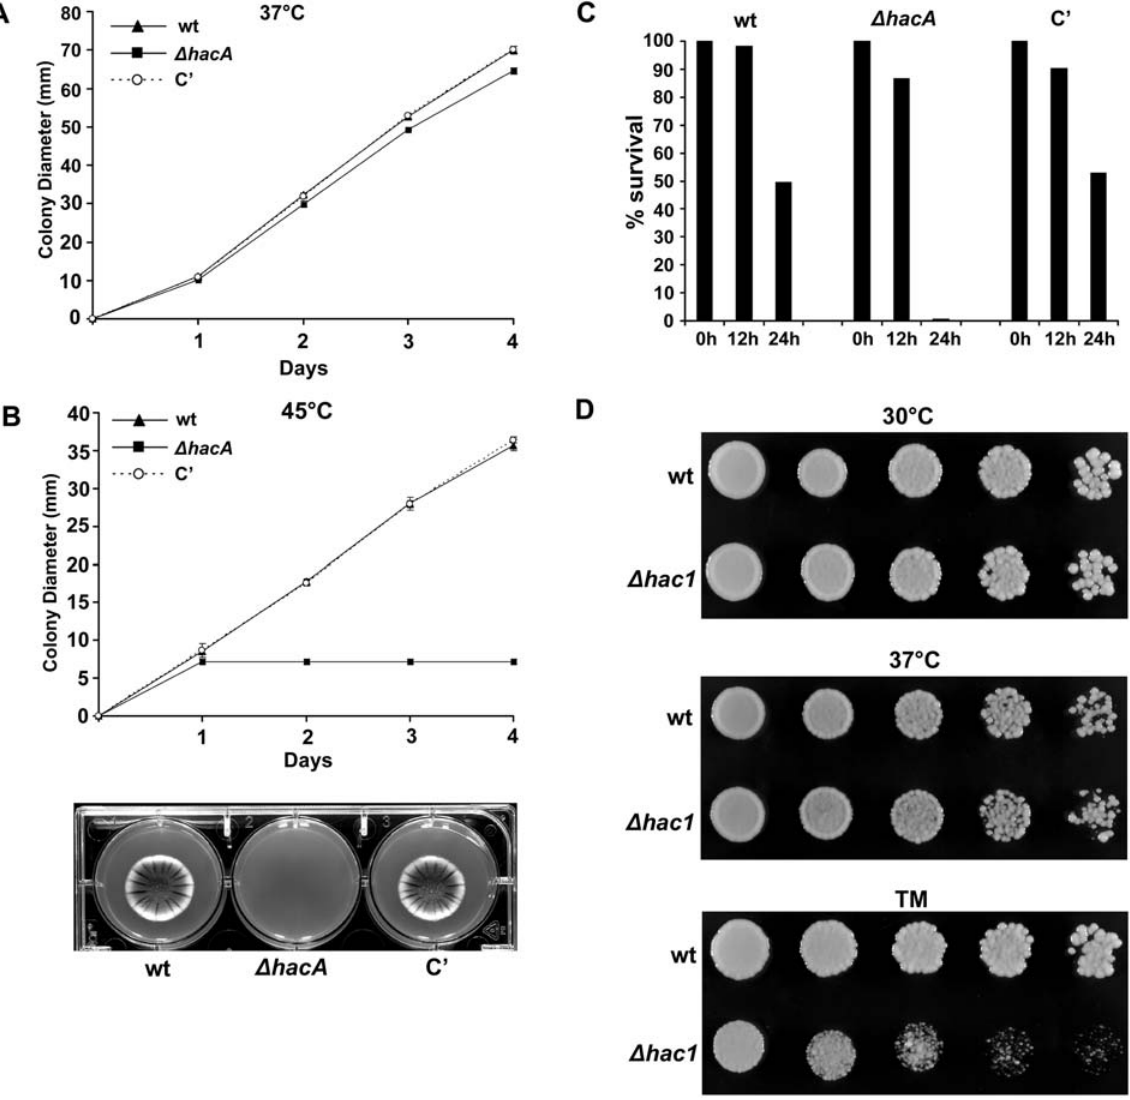
Figure 5. hacA is required for growth under thermal stress. Growth of D hacA at 37 u C and 45 u C: A 5 m l suspension of conidia from the indicated strains was spotted onto the center of an IMA plate and incubated at 37 u C (A) or 45 u C (B) for 4 days. The experiment was performed in triplicate, and colony diameter was measured daily. Values represent the mean 6 SD. Colony morphology after 2 days of growth at 45 u C is shown in (B). (C) Reduced survival of D hacA at 45 u C: 200 conidia from the indicated strains were spread in triplicate onto the surface of IMA plates. After incubating at 45 u C for 0 h, 12 h, or 24 h, the plates were placed at 37 u C and the percentage of surviving CFUs was determined. (D) Temperature sensitivity of S. cerevisiae D hac1 : Serial 5-fold dilutions of the wt and the D hac1 mutant were spotted onto YPD plates and incubated at 30 u C and 37 u C for 2 days. Confirmation that the D hac1 mutant is hypersensitive to ER stress was shown by inoculating wt and the D hac1 mutant onto YPD containing 62.5 ng/ml TM and incubating at 30 u C for 2 days. Experiments were performed three times with similar